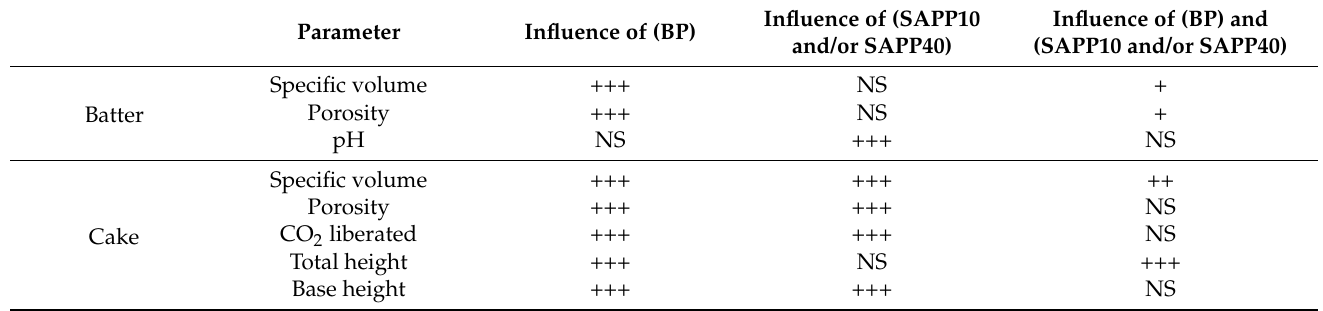
Table 3. Summary of significance level for the effect of BP, SAPP10 and SAPP40 on batter and cake